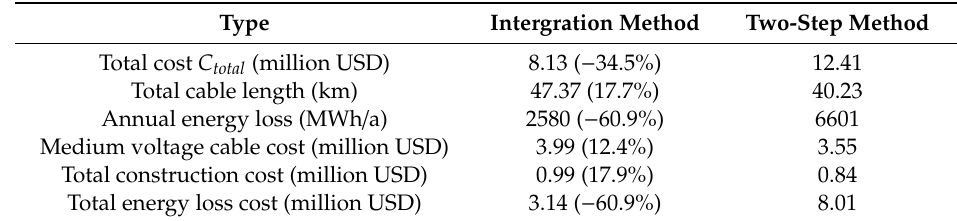
Figure 12. Comparison of lengths of different cross-sectional cables used in the topology. Table 4. Summary of total cable usage and cost (references for the % are the values obtained by the two-step method).